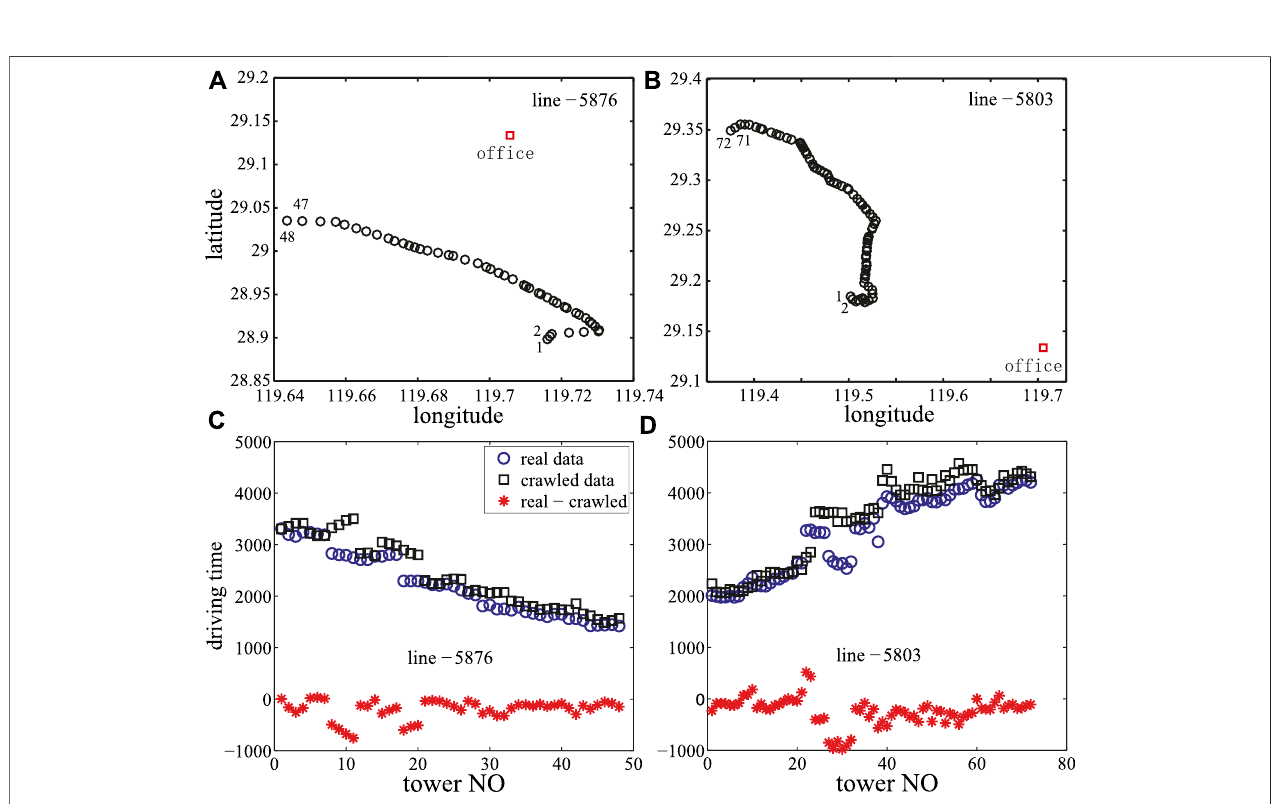
FIGURE 2 | (color online) (A,B) Longitudes and latitudes of towers for line-5876 and line-5803. Only the fi rst two towers and the last two towers, as well as the location of the of fi ce, are marked. (C,D) Real driving time and the crawled driving time from the of fi ce to each tower for line-5876 and line-5803, and the red star curve stands for the difference. There are 48 towers in line-5876 and 72 towers in line-5803.